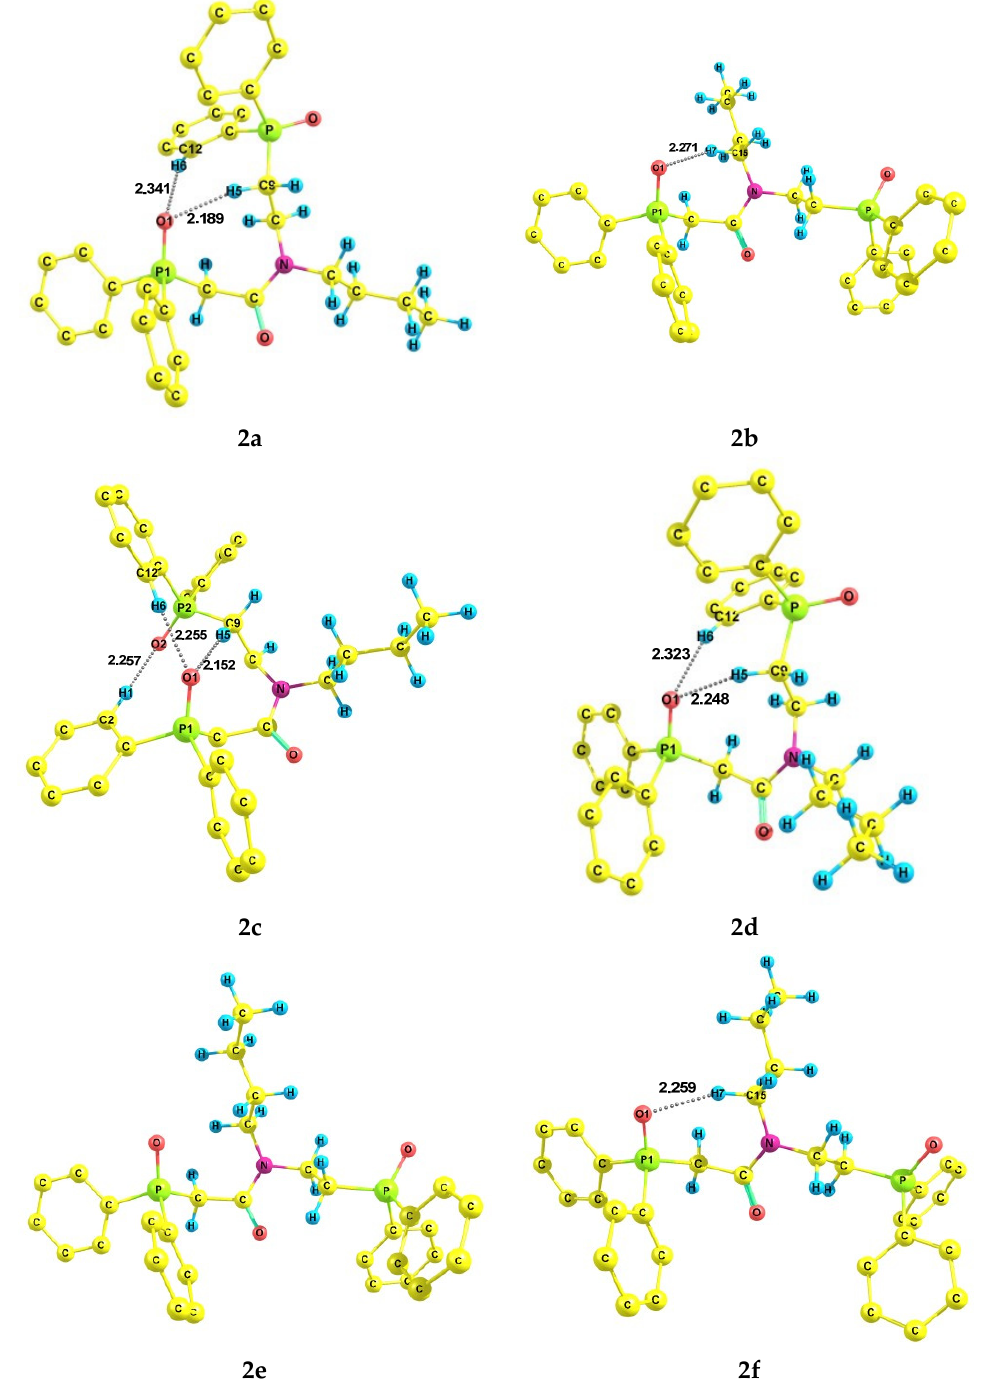
Figure 2. Preferred conformers of 2 according to DFT calculations (some hydrogen atoms are omitted). Distances are given in Å.